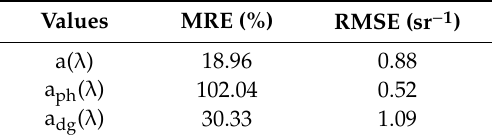
Table 7. Evaluation of the errors between measured and derived values.